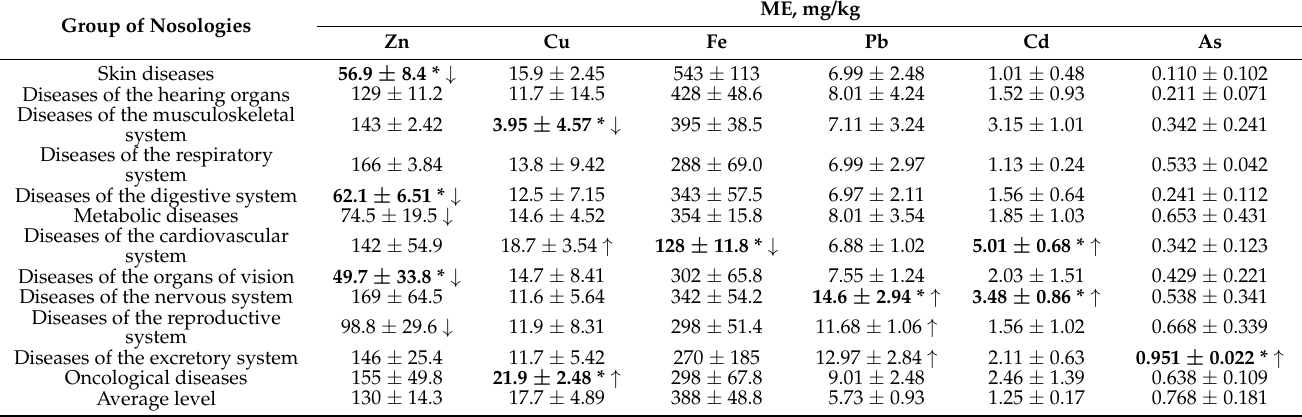
Table 2. The MME level (mg/kg) in animal biological media, taking into account past